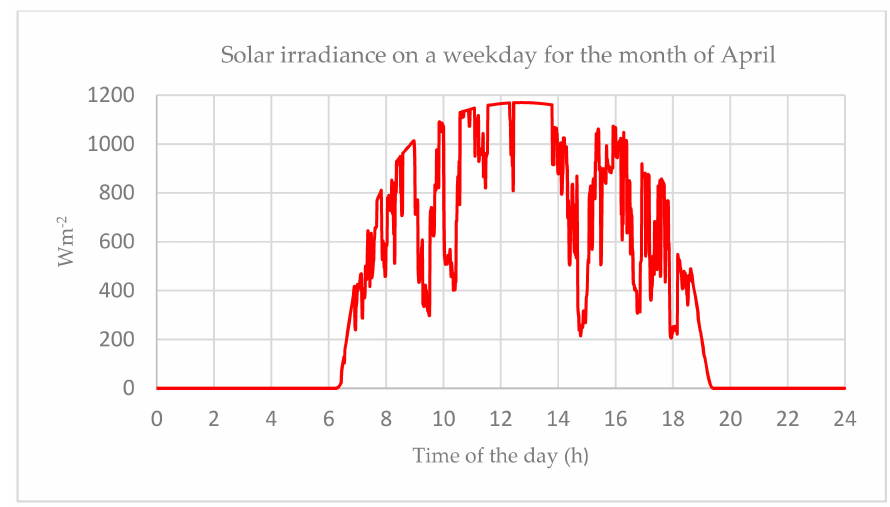
Figure 6. Solar Irradiance on weekday for the month of April over 24 h.